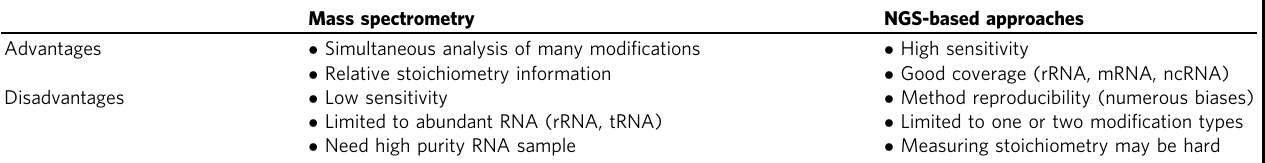
Table 1 Comparison between mass spectrometry and next generation sequencing (NGS) approaches for the analysis of RNA modi fi